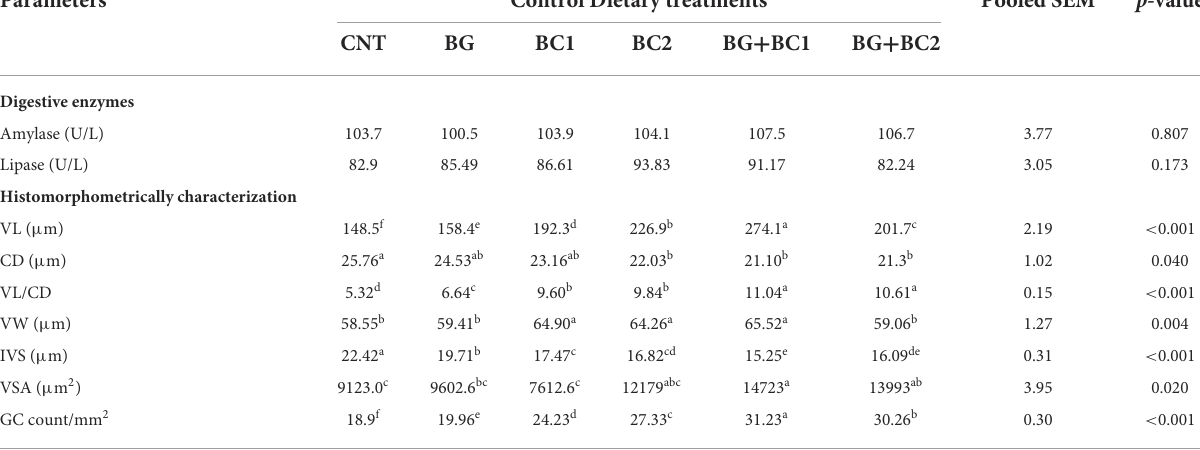
TABLE 7 Effects of dietary supplementation with β -glucan and/or Bacillus coagulans on intestinal digestive enzymes and histomorphometry features of tilapia fish. Parameters Control Dietary treatments Pooled